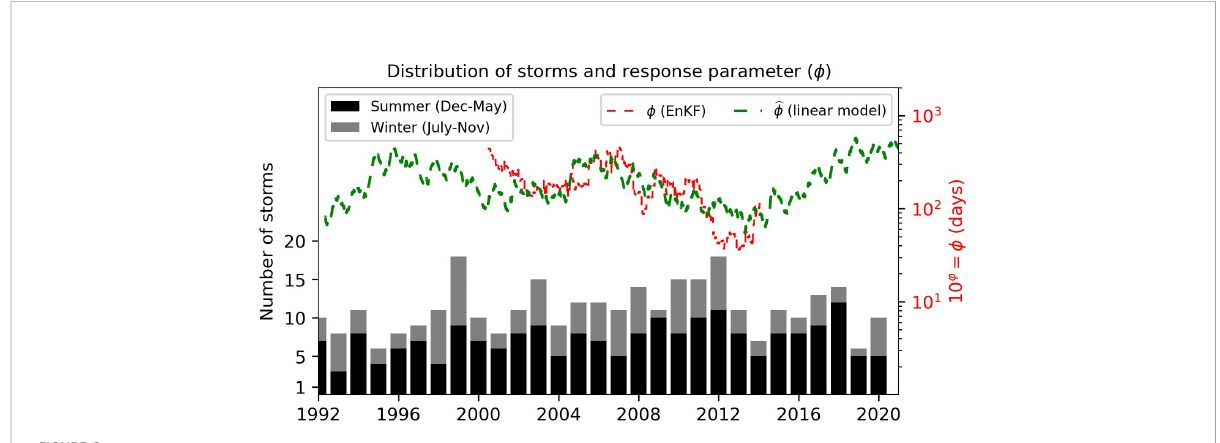
FIGURE 6 Bar chart and left axis: multi-decadal distribution of storm events per year and season (summer and winter). Storm events were obtained using a peak-over-threshold method over the long-term timeseries of signi fi cant wave height at the breaking position (i.e., H s,b > H 95% and H s,b > H 75% for at least 24 hours, Masselink et al., 2014). The green and red dashed lines (right axis) show the estimated (EnKF) and modelled magnitude of the f parameter (pearson correlation with total number storms per year = -0.26, pvalue =